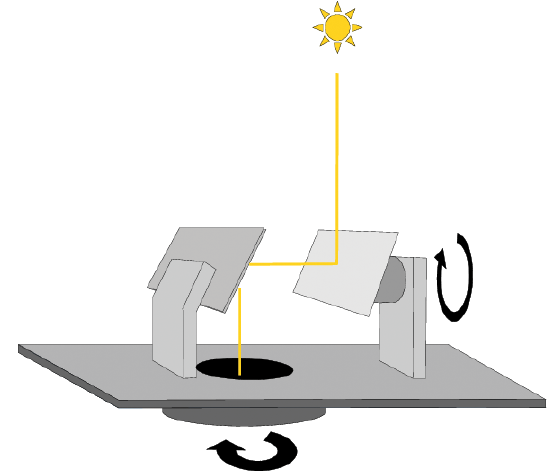
Fig. A1. The solar tracker, built in the workshop of the University of Bremen. In principle the solar tracker consists of two mirrors mounted on a metal frame. The whole metal frame and one solar mirror are movable with rotation stages. For the positioning of the solar tracker mirrors a motion controller is used. The calculation of the positioning is realized in the automation software (Sect.